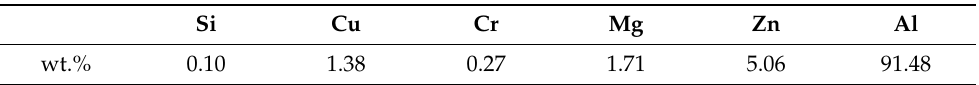
Table 1. Chemical composition of the AA7075 raw powder determined from EDX analysis. Si Cu Cr Mg Zn Al wt.% 0.10 1.38 0.27 1.71 5.06